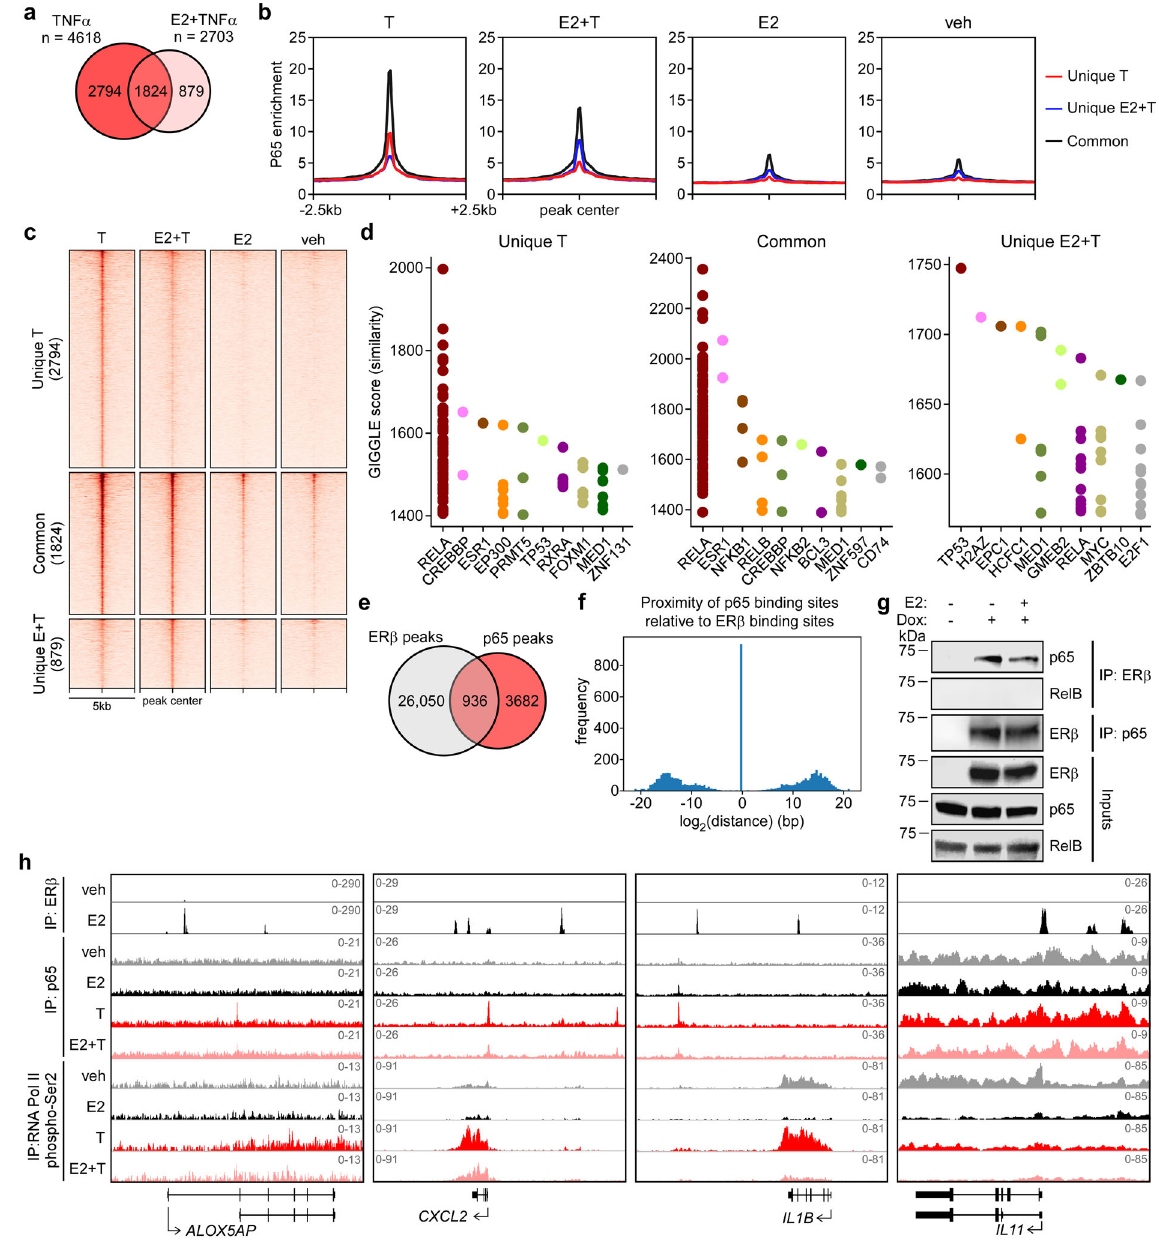
Fig. 4 ER β interacts with p65 and alters its genomic localization. a Venn diagram depicting overlap of p65 binding sites following TNF α or E2 + TNF α stimulation in dox treated MDA-MB-231-ER β cells as determined by ChIP-seq. b Aggregate plots and ( c ) heat maps of p65 binding intensity in the presence of TNF α alone (Unique T), E2 + TNF α (Unique E + T), or both (Common) following indicated treatments. d GIGGLE analysis of identi fi ed p65 binding sites assessing their similarity with other known protein binding sites in publicly available datasets. e Venn diagram depicting overlap of ER β and p65 binding sites identi fi ed via ChIP-seq. f Bar graph of all p65 binding sites and their distribution relative to ER β binding sites. Note the 936 overlapping sites from ( e ) are at the exact same genomic location. g Co-immunoprecipitation experiments using nuclear lysates from dox treated MDA-MB-231-ER β cells demonstrating protein interactions between ER β and p65, but not RELB. h ChIP-seq tracks from IGV for ER β , p65, and RNA Polymerase II phospho-Ser2 ChIP-seq following dox plus veh, E2, T, and E2 + T treatment at NF κ B/p65 target gene loci. See also Figure